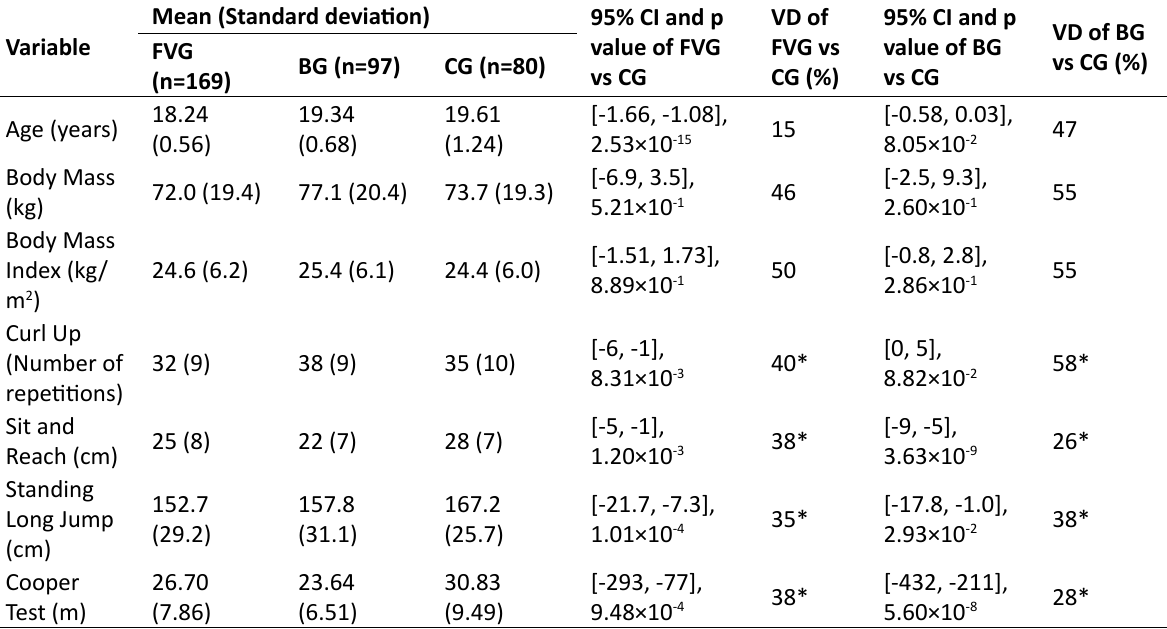
Table 1. Differences in baseline data of exercise groups to control group